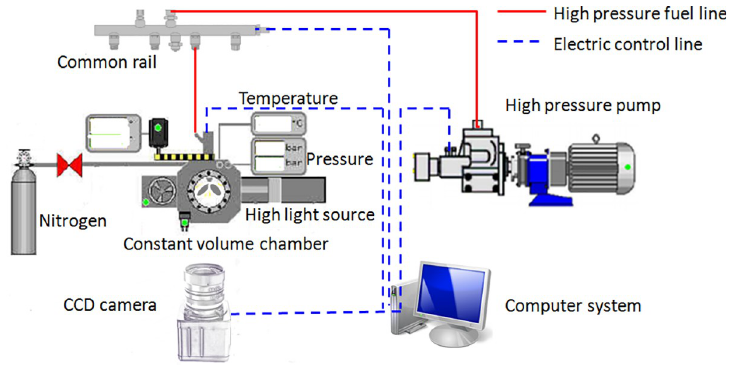
Fig 4. Visualization spray test